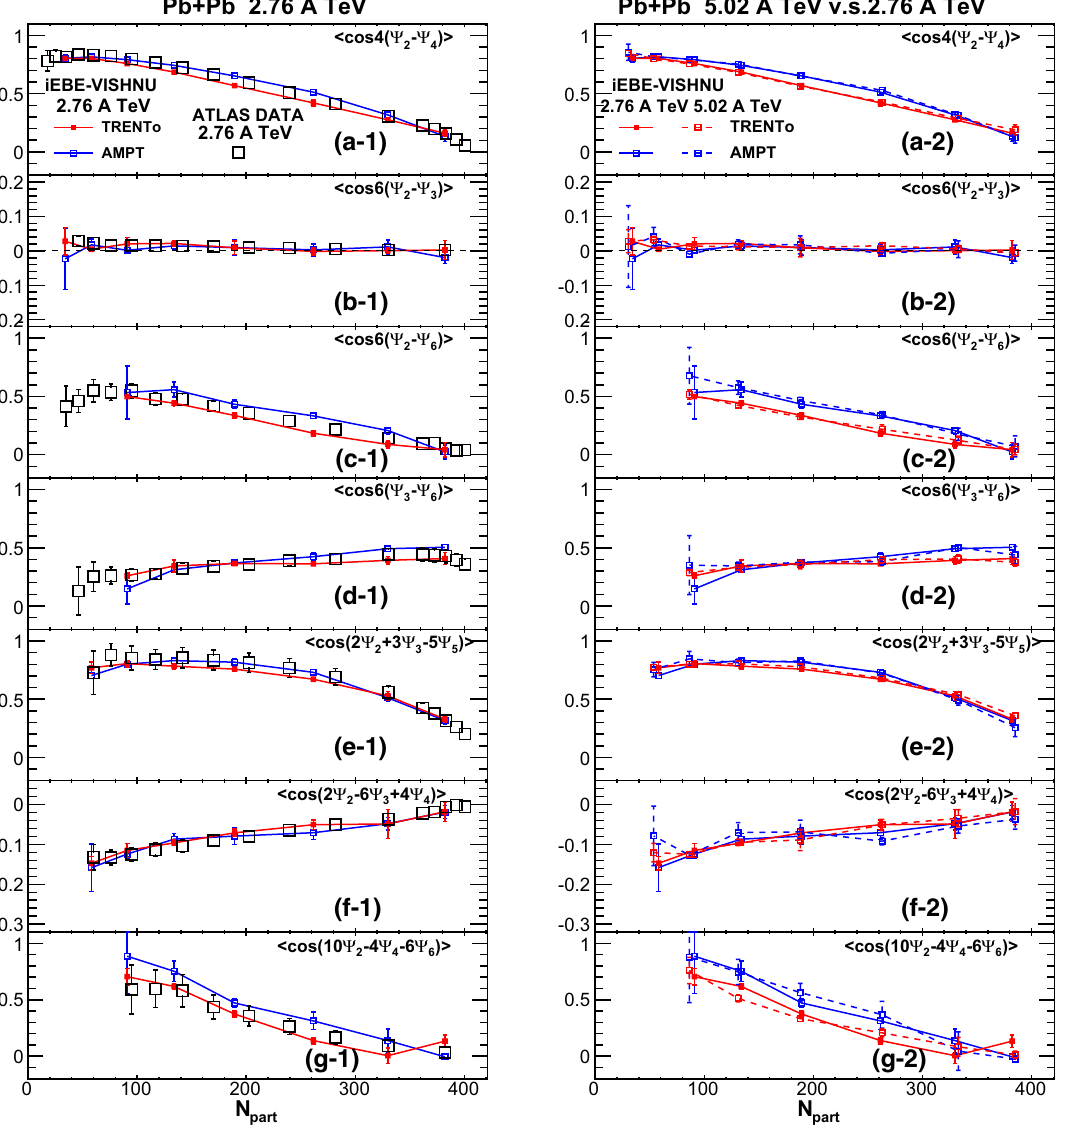
Fig. 8 Event-plane correlations as a function of participant number in Pb + Pb collisions at 2.76 and 5.02 A TeV, calculated from iEBE-VISHNU with TRENTo and AMPT initial conditions. The data at 2.76 A TeV are taken from the ATLAS paper [31], and the N part values are taken from [31,72]